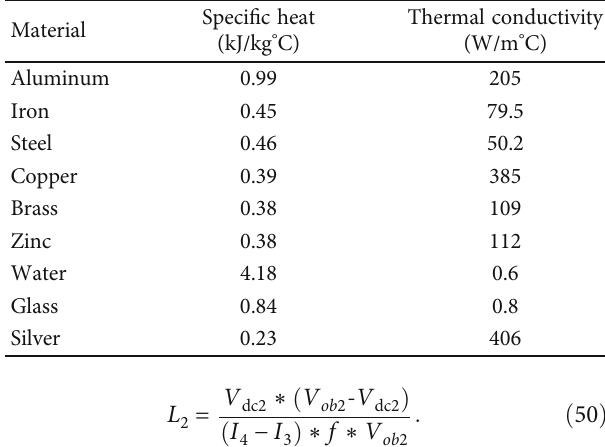
Table 6: Properties of various